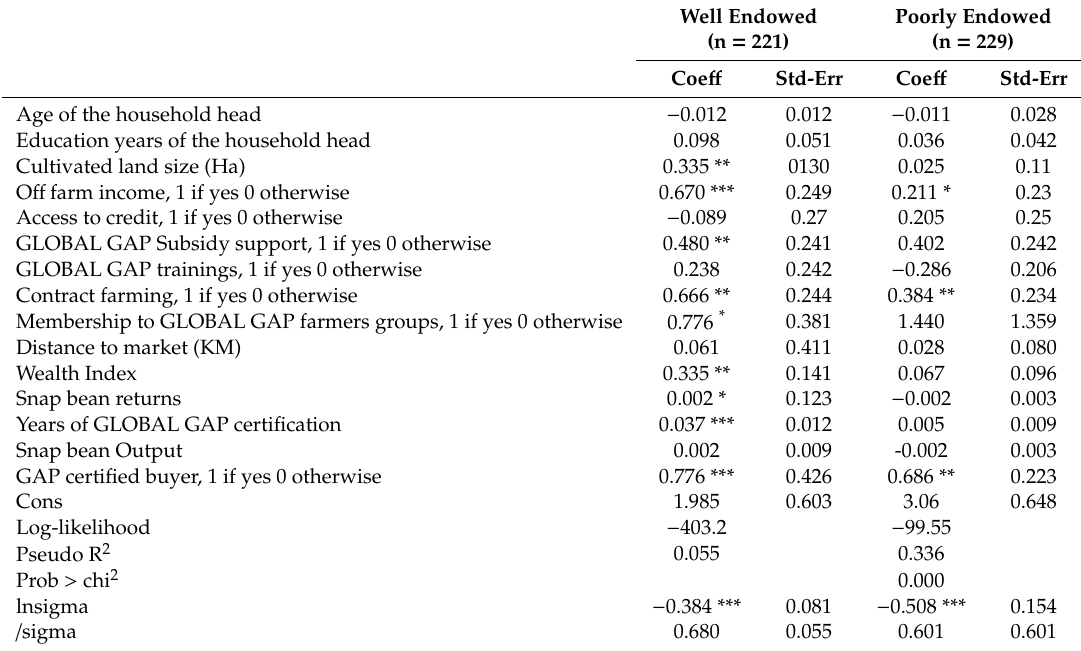
Table 5. Hurdle II Extent GAP of